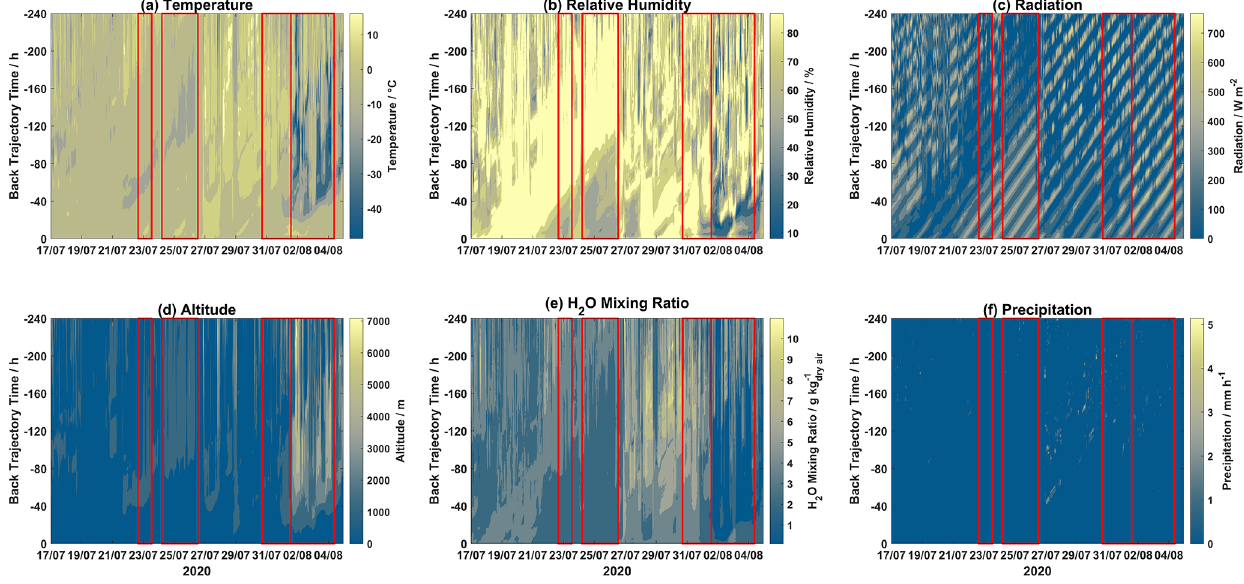
Figure 4. Contour plots of trajectory-derived meteorological parameters, i.e., (a) temperature, (b) relative humidity, (c) solar radiation, (d) altitude, (e) H 2 O mixing ratio, and (f) precipitation, along each trajectory for the 2020 campaign. Event periods are outlined in red. The x axis displays arrival time at Villum, the y axis displays hours backward in time for each trajectory, and the color bar represents the meteorological